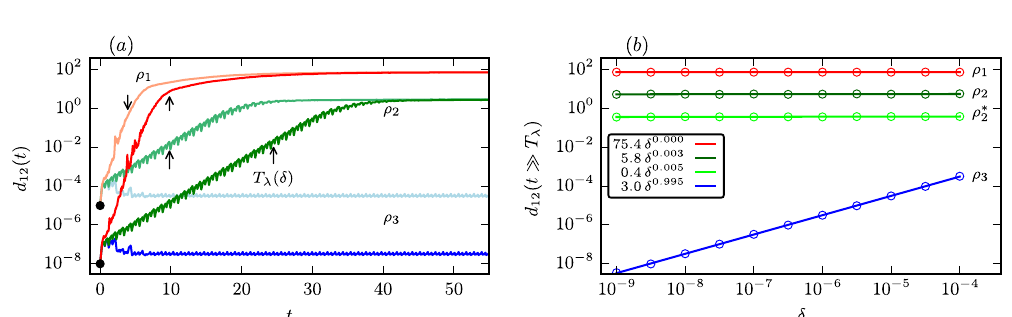
Figure 3. Distance scaling of initially close-by trajectories. ( a ) The distance d 12 ( t ) of initially close-by pairs of trajectories, averaged over 10 4 initial conditions, with initial distances d 12 (0) = δ = 10 − 8 and δ = 10 − 5 (black bullets). For the regular flows ( ρ = ρ 3 = 181, blue lines) the long-term distance depends on δ . The strongly chaotic attractor ( ρ = ρ 1 = 180.7, red lines) approaches the maximal distance independently of the initial distance within the respective Lyapunov prediction time T λ . In the case of PPC ( ρ = ρ 2 = 180.78, green lines) the distances reach a quasi stationary plateau that is independent of the initial distance. For comparison we marked the Lyapunov prediction times T λ at the respective curves by arrows. ( b ) The scaling behavior, see Eq. (2), of the averaged long-term distance d 12 ( t = 200). The results (circles) are for the strongly chaotic phase ( ρ = ρ 1 , top), for the partially predictable chaos ( ρ = ρ 2 and ρ ρ = ⁎ , middle) and for a limit cycle ( ρ = ρ 3 = 181.10, bottom), 2 as indicated in Fig. 1. The respective solid lines are linear fits to the log-log